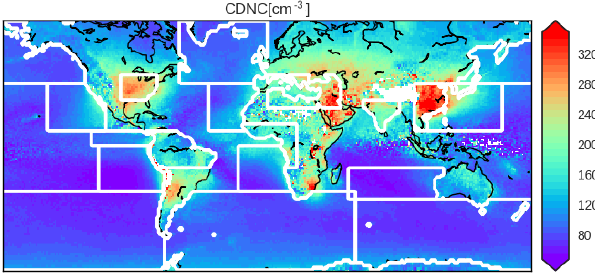
Figure 1. The mean CDNC from 2003–2015 observed by MODIS. Boxes over land and ocean used to examine different regimes in Fig. 3 are shown in